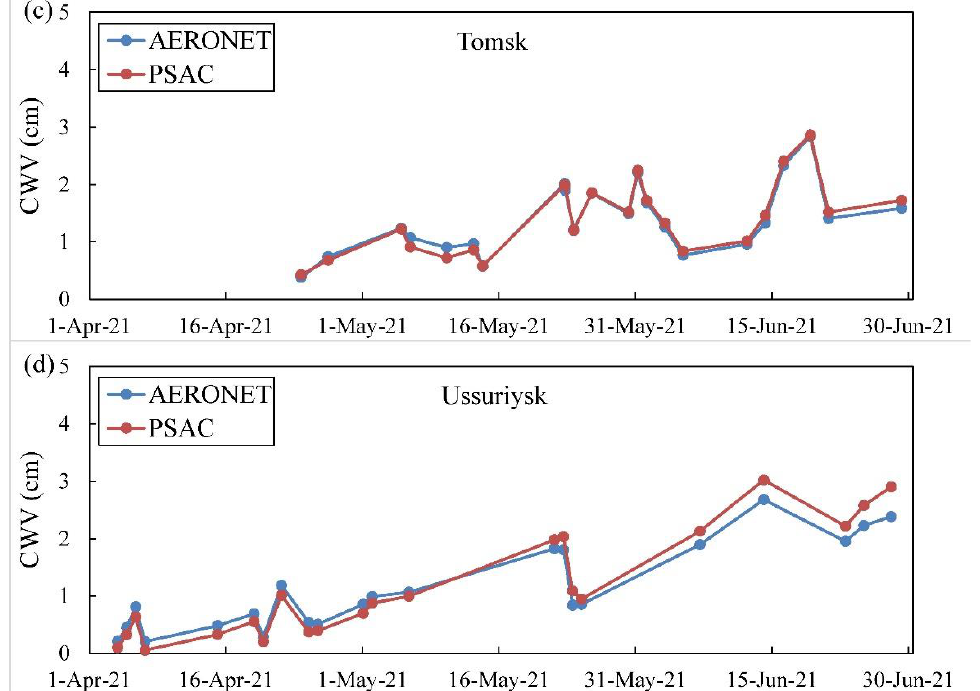
Figure 6. Day-to-day comparisons between PSAC CWV data and AERONET CWV data. ( a ) NEON_LENO. ( b ) SEDE_BOKER. ( c ) Tomsk. ( d ) Ussuriysk.